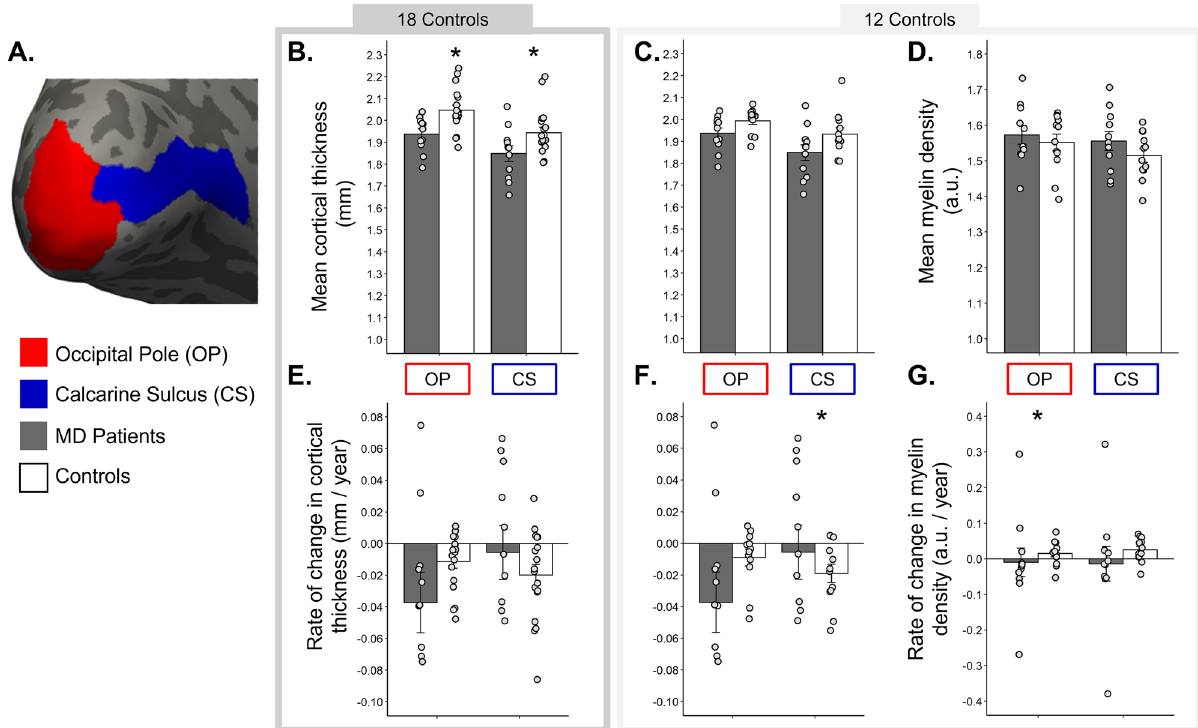
Figure 4. ( A ) Regions of interest (ROIs) on the inflated cortical surface for MD patient (black bars) and sighted controls (white bars). Error bars = SEM. ( B , C ) Mean cortical thickness (mm) for occipital pole and calcarine sulcus. ( B ) = MD patients and C1–C18. ( C ) = MD patients and C1–C12, the subset of controls that contribute myelin data. ( D ) Mean myelin density for MD patients and C1–C12. ( E , F ) Rate of change in cortical thickness (mm/year) for MD patients and C1–C18 ( E ) and MD patients and C1–C12 ( F ). ( G ) Rate of change in myelin density (units per year) for MD patients and